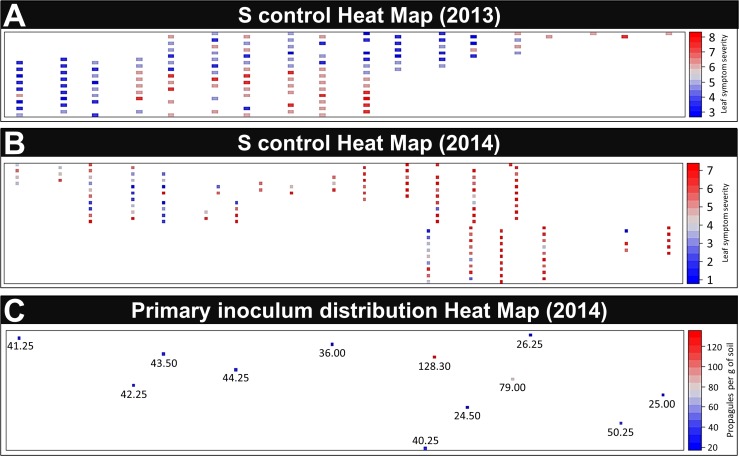
Heat maps of symptomatic control disease in 2013 (A) and 2014 (B) obtained by using a 1-to-9 scale and primary inoculum quantification in 2014 in number of microsclerotia per gram of soil (C).